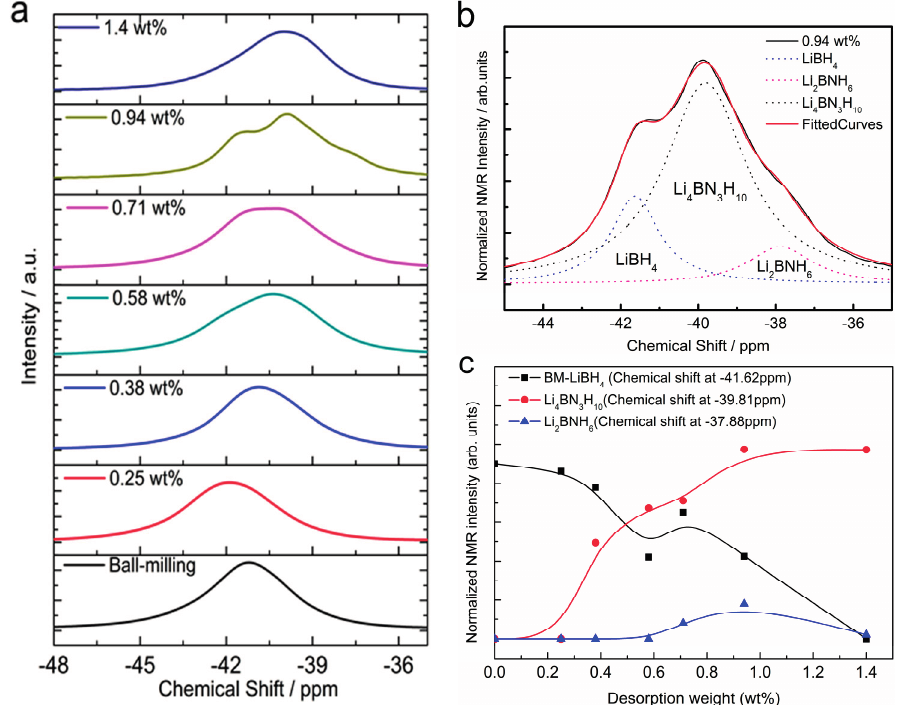
Figure 8. ( a ) 11 B magic angle spinning (MAS) NMR spectra of T 2 (2Mg(NH 2 ) 2 –3LiH–LiBH 4 ) samples collected at 460 K at different degree of dehydrogenation: fresh-made, 0.25 wt%, 0.38 wt%, 0.58 wt%, 0.71 wt%, 0.94 wt%, and 1.4 wt%; ( b ) hydrogen desorption fitted NMR spectra of Figure 8a (0.94 wt%) in comparison with LiBH 4 , Li 2 BNH 6 and Li 4 BN 3 H 10 ; and ( c ) the normalized 11 B magic angle spinning (MAS) NMR peak intensities of LiBH 4 ( − 41.62 ppm), Li 2 BNH 6 ( − 37.88 ppm) and Li 4 BN 3 H 10 ( − 39.81 ppm) in samples with different degree of hydrogen